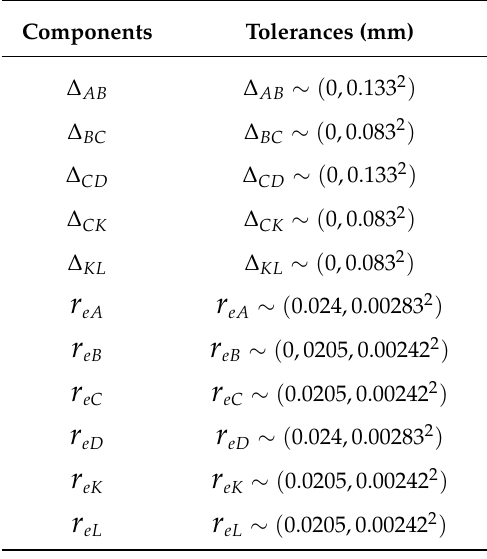
Table 6. Primary tolerance design parameters.